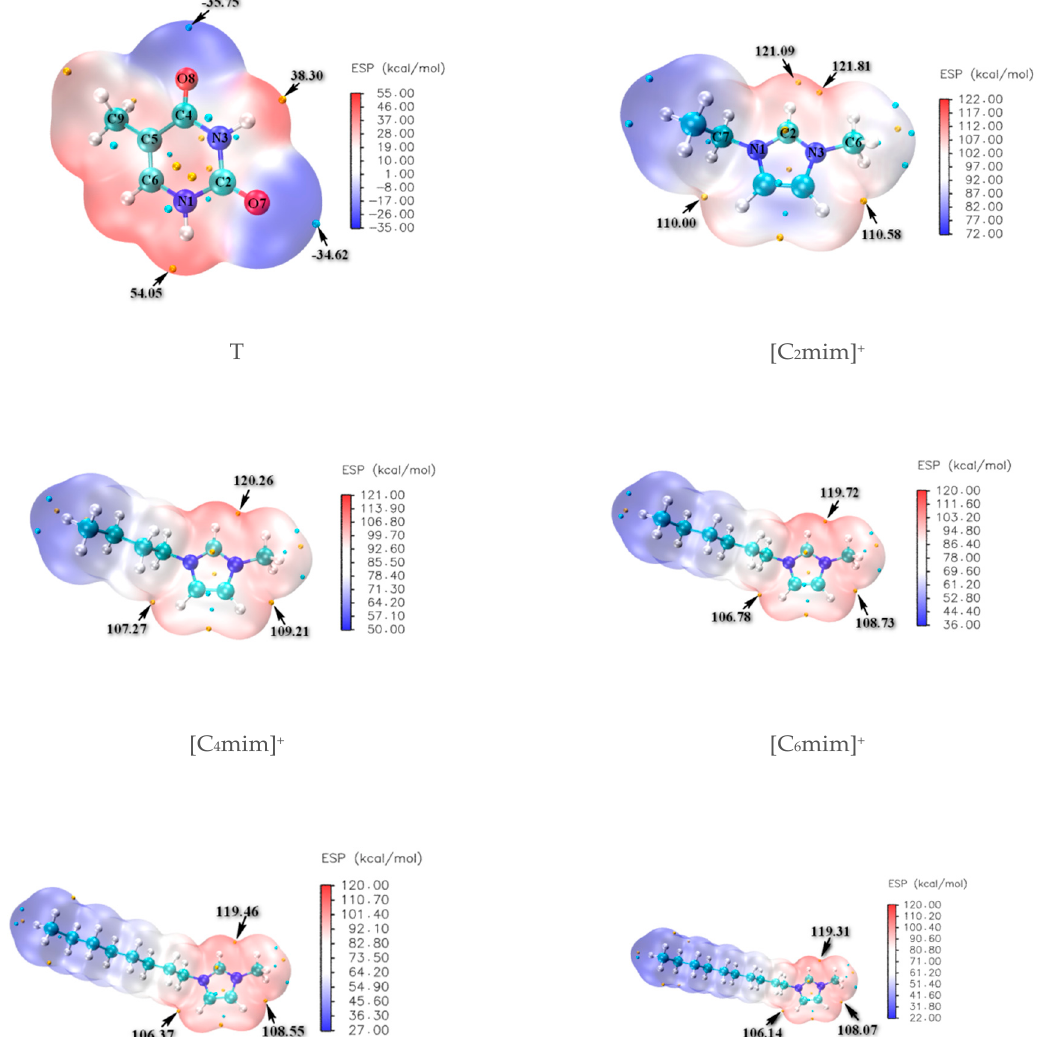
Figure 1. Molecular electrostatic potential (MEP) maps of the thymine (T) and imidazolium cations -[C n mim] + ( n = 2, 4, 6, 8,